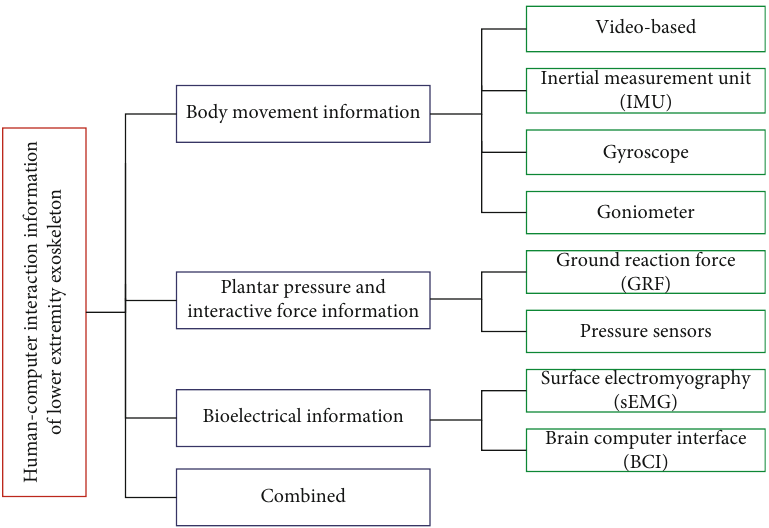
Figure 1: Tree diagram displaying available gait